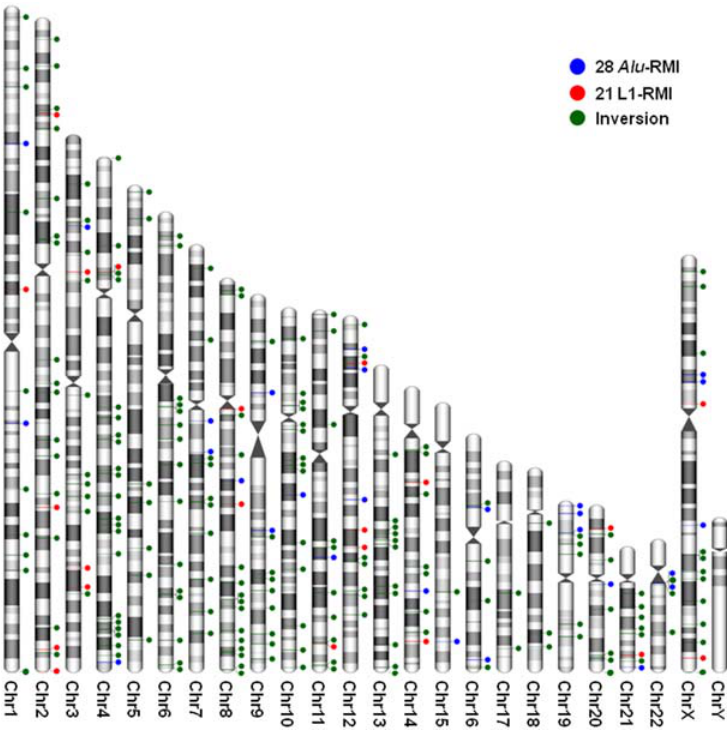
Figure 1. The 252 inversion loci between the human and chimpanzee lineages. Blue and red circles indicate Alu -RMI and L1-RMI events, respectively. All inversions except for those caused by RRMI are indicated by green circles. The karyotype images were created using the idiographica webtool [58].